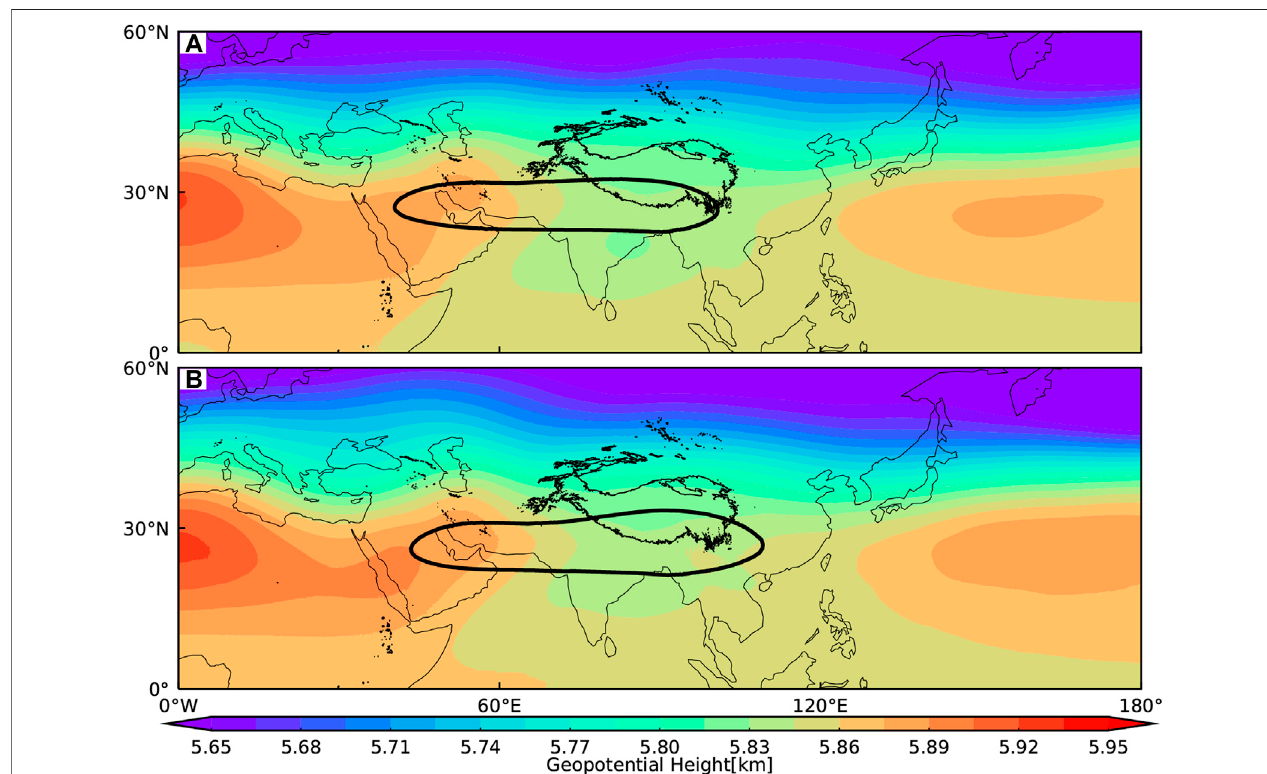
FIGURE 15 | The composite500 hPa geopotential height (shading, unit: km) and the SAH region (solid lines, 12,520 gpm geopotential height isolines) for the EOF time series 3 in the (A) stronger years and (B) weaker years.